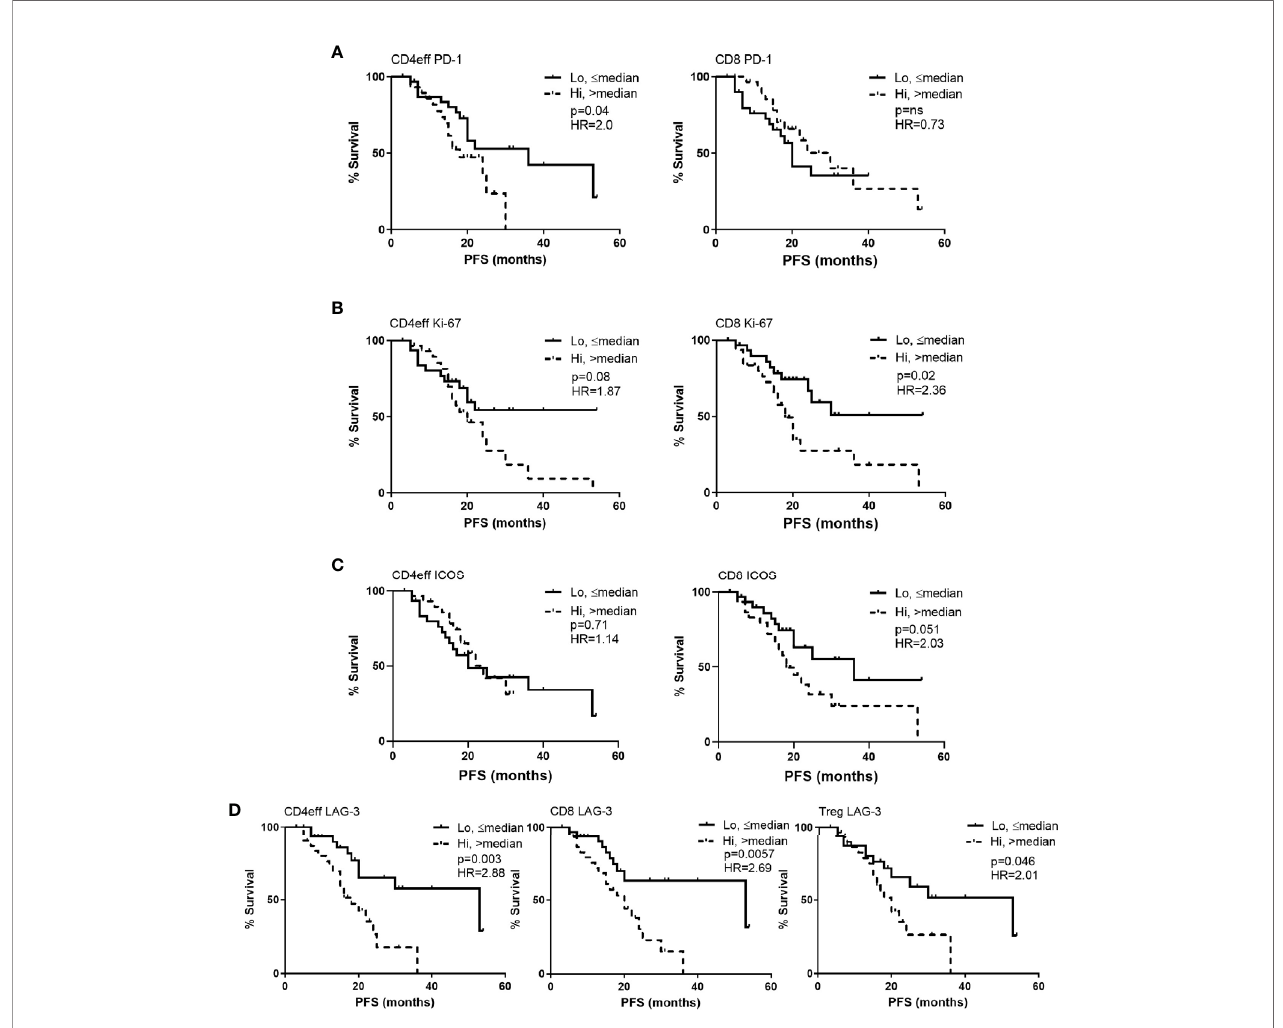
FIGURE 2 | Kaplan-Meier estimates of progression free survival (PFS) according to frequency of PD-1, Ki-67, ICOS and LAG-3 positivity in CD4eff, CD8 and Treg cells in bone marrow of MM patients at D100 post ASCT. High refers to frequency that is above median, and low equal to or below median of (A) PD-1, (B) Ki-67, (C) ICOS, and (D) LAG-3 on T cell subsets as indicated. CD4eff PD-1 refers to the % of CD4eff that are PD-1 positive, Treg LAG-3 refers to the % of Treg that are LAG-3 positive, etc. Statistical analysis by Log-Rank.